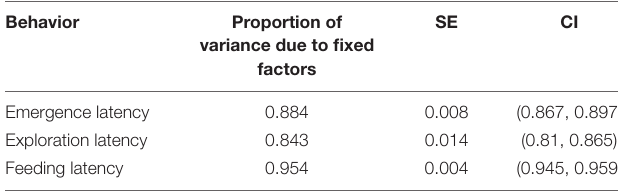
TABLE 6 | Proportion of variance caused due to fixed factors during calculation of enhanced agreement repeatability for Fish ID across